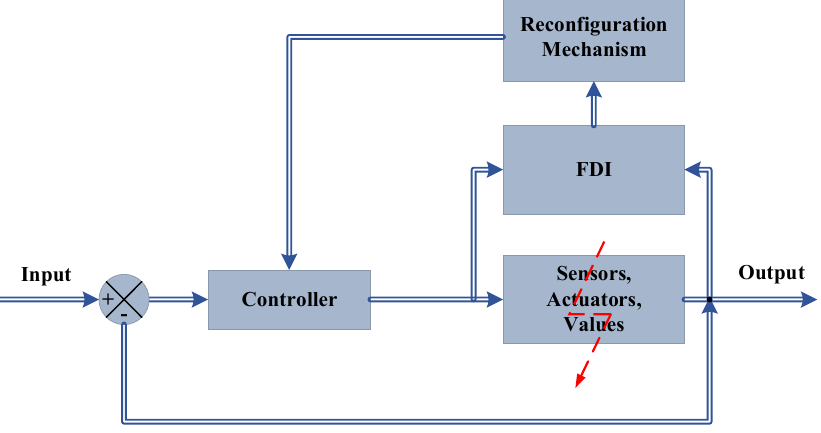
Figure 3. The active fault-tolerant control [1].